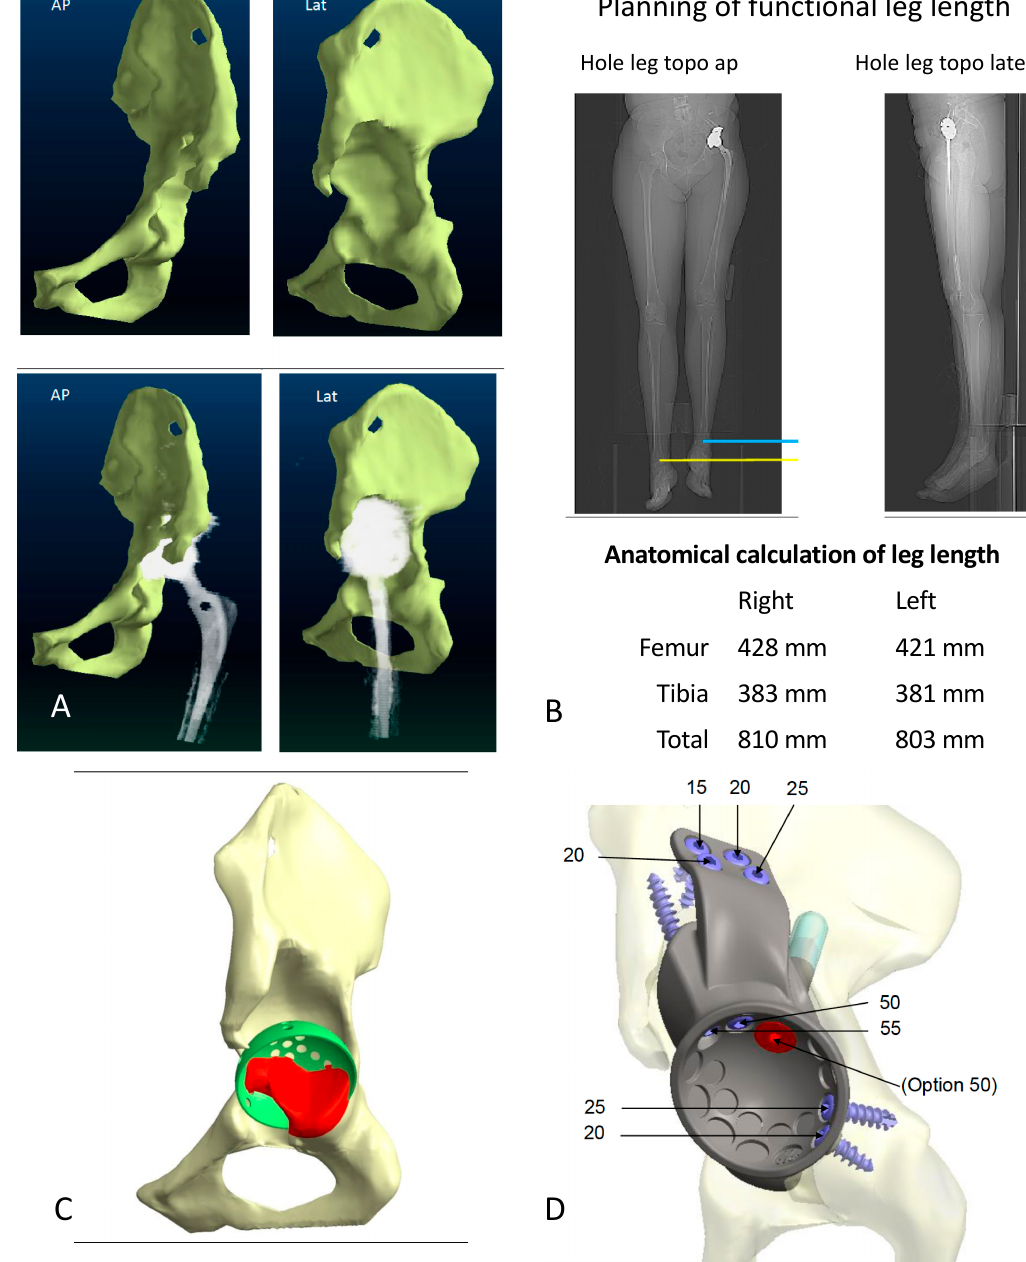
Figure 1. Selected templating steps for a custom made monoflanged acetabular component (CMAC) with optional stem for intra- and extramedullary iliac fixation for a Paprosky IIIA defect: ( A ) Assessment and 3D visualization of the defect situation with and without subtraction of the implant. ( B ) CT-based estimation of leg length discrepancy (LLD) respecting pelvic tilt and joint contractures. ( C ) Virtual reconstruction of the hip center of rotation (COR) by positioning a standard acetabular component of a specific size at the anatomical COR. Bone that has to be reamed to position the original implant is colored in red. ( D ) Design features of the CMAC: The large segmental iliac defect is filled by the implant’s metallic monoblock assembled socket. Screws are positioned in areas of the pelvis that are characterized by intact host bone with a recommendation for their length in millimeters. For further primary stability, the surgeon can implant an additional intramedullary press-fit stem (entrance point colored in red). Planning and defect classification have previously been described in detail by our group